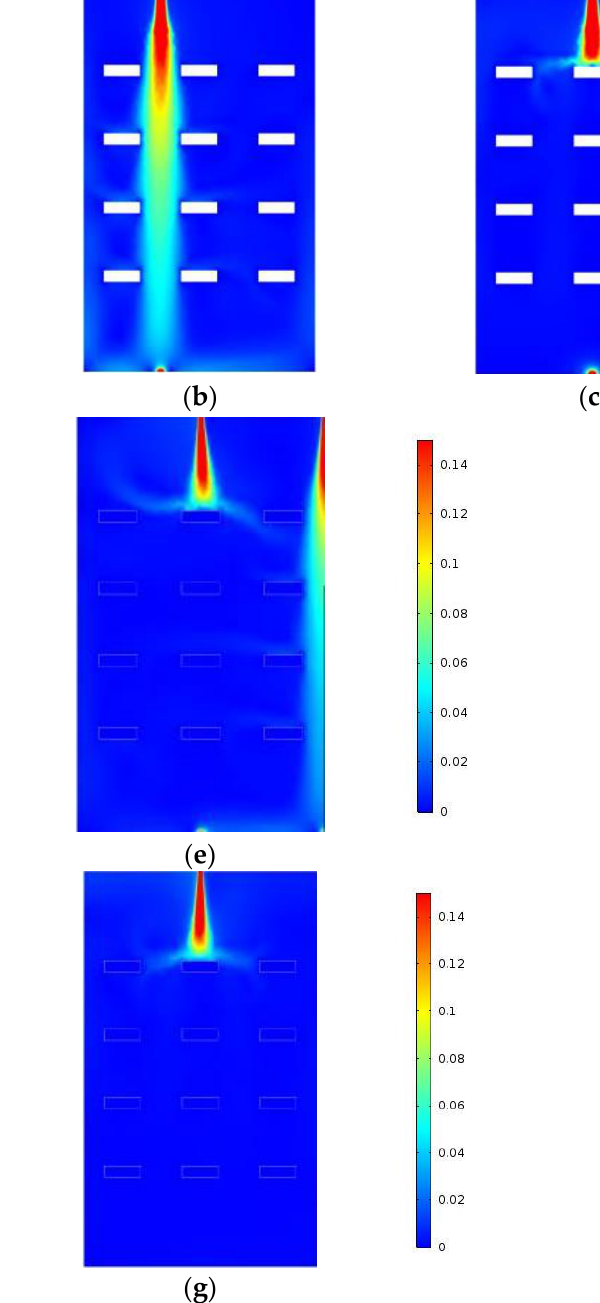
Figure 22. Flow field distribution chart of the reservoir under different water distribution modes: ( a ) one-inlet – one-outlet; ( b ) two-inlets – two-outlets-a; ( c ) two-inlets – two-outlets; ( d ) three-inlets – three-outlets-a; ( e ) three-inlets – three-outlets-b; ( f ) four-inlets – four-outlets; and ( g ) four-inlets – one-outlet.